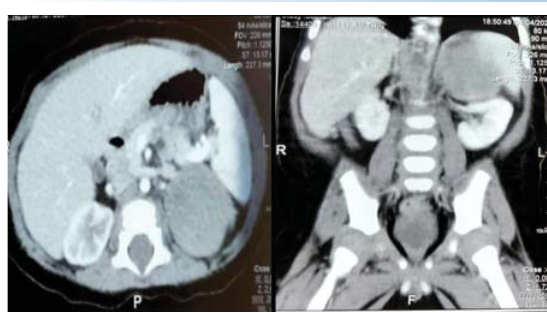
Figure 1. CECT of the abdomen revealing a suprarenal mass with displaced kidney without